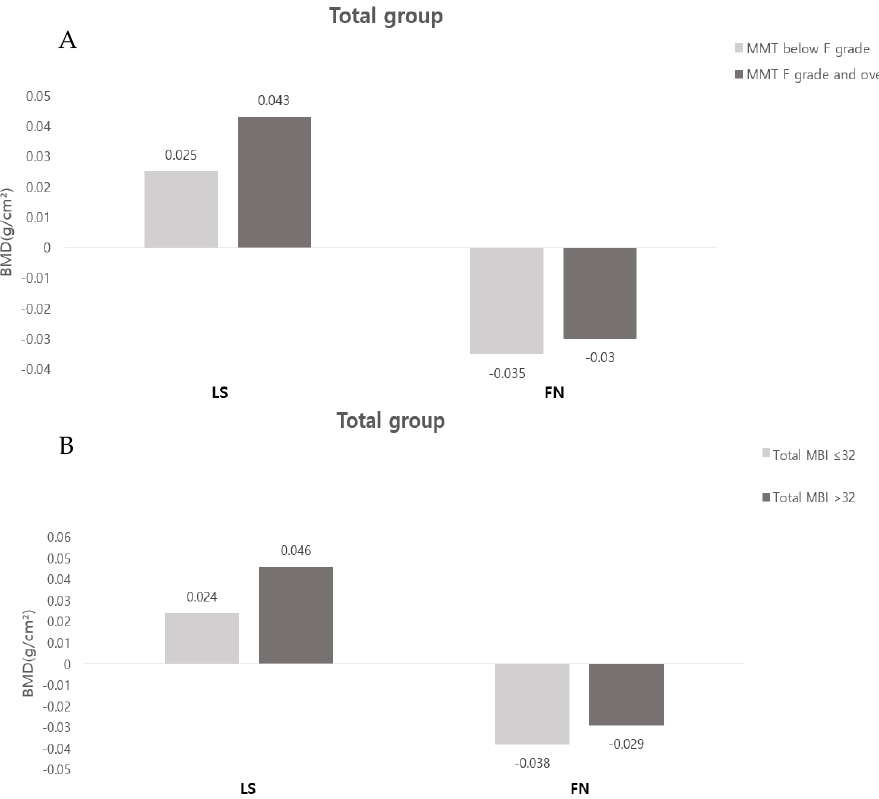
Figure 1. Changes in absolute BMD according to FAC: ( A ) total group; ( B ) osteoporosis group; ( C ) osteopenia group. Abbreviations: LS, lumbar spine; FN, femoral neck; FAC, functional ambulatory category; * p < 0.05 was analyzed by independent t -test.